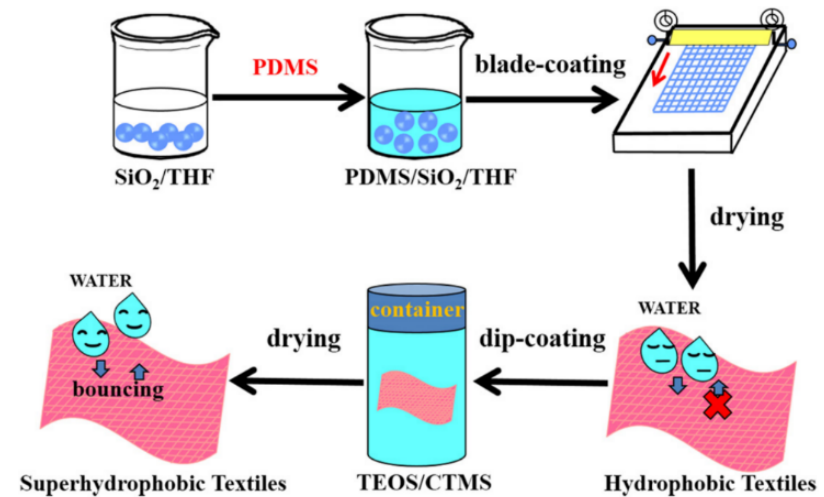
Figure 6. Illustration of the fabrication of superhydrophobic textiles with water pressure resistance (Reproduced from [42], with kind permission of Elsevier).